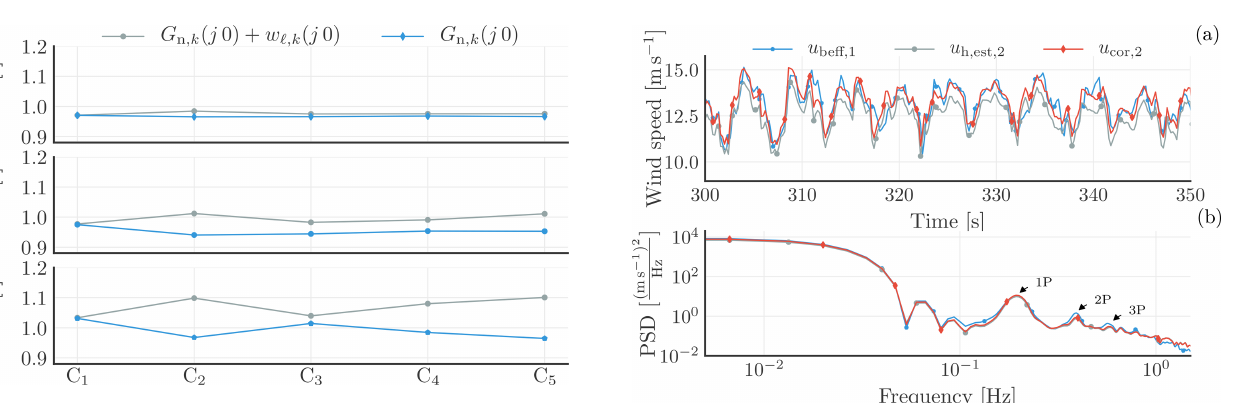
Figure 11. A selected time series of the blade effective wind speed from blade 1 ( u beff , 1 ) and the estimated ( u h, est , 2 ) and cor- rected ( u cor , 2 ) inflow wind speeds from blade 2 in the rotating frame of reference shown in (a) . The power spectral densities (PSDs) of the three signals are displayed in the lower plot.